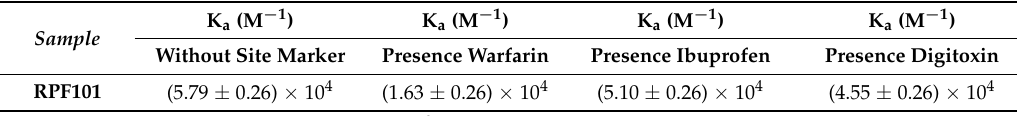
Figure 7. Modified Stern-Volmer plot for the interaction HSA: RPF101 in the presence of each site marker: warfarin, ibuprofen and digitoxin (1.00 × 10 − 5 M). [HSA] = [warfarin] = [ibuprofen] = [digitoxin] = 1.00 × 10 − 6 M and [ RPF101 ] = 0.17; 0.33; 0.50; 0.66; 0.83; 0.99; 1.15; 1.32 × 10 − 5 M. Table 2. K a value for the interaction HSA: RPF101 without and in the presence of warfarin, ibuprofen, or digitoxin at 310 K a .